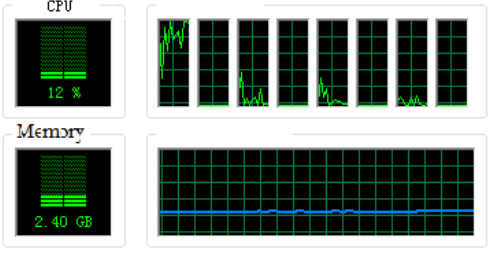
Figure 5 Acceleration efficiency before using OpenMP parallel processing model